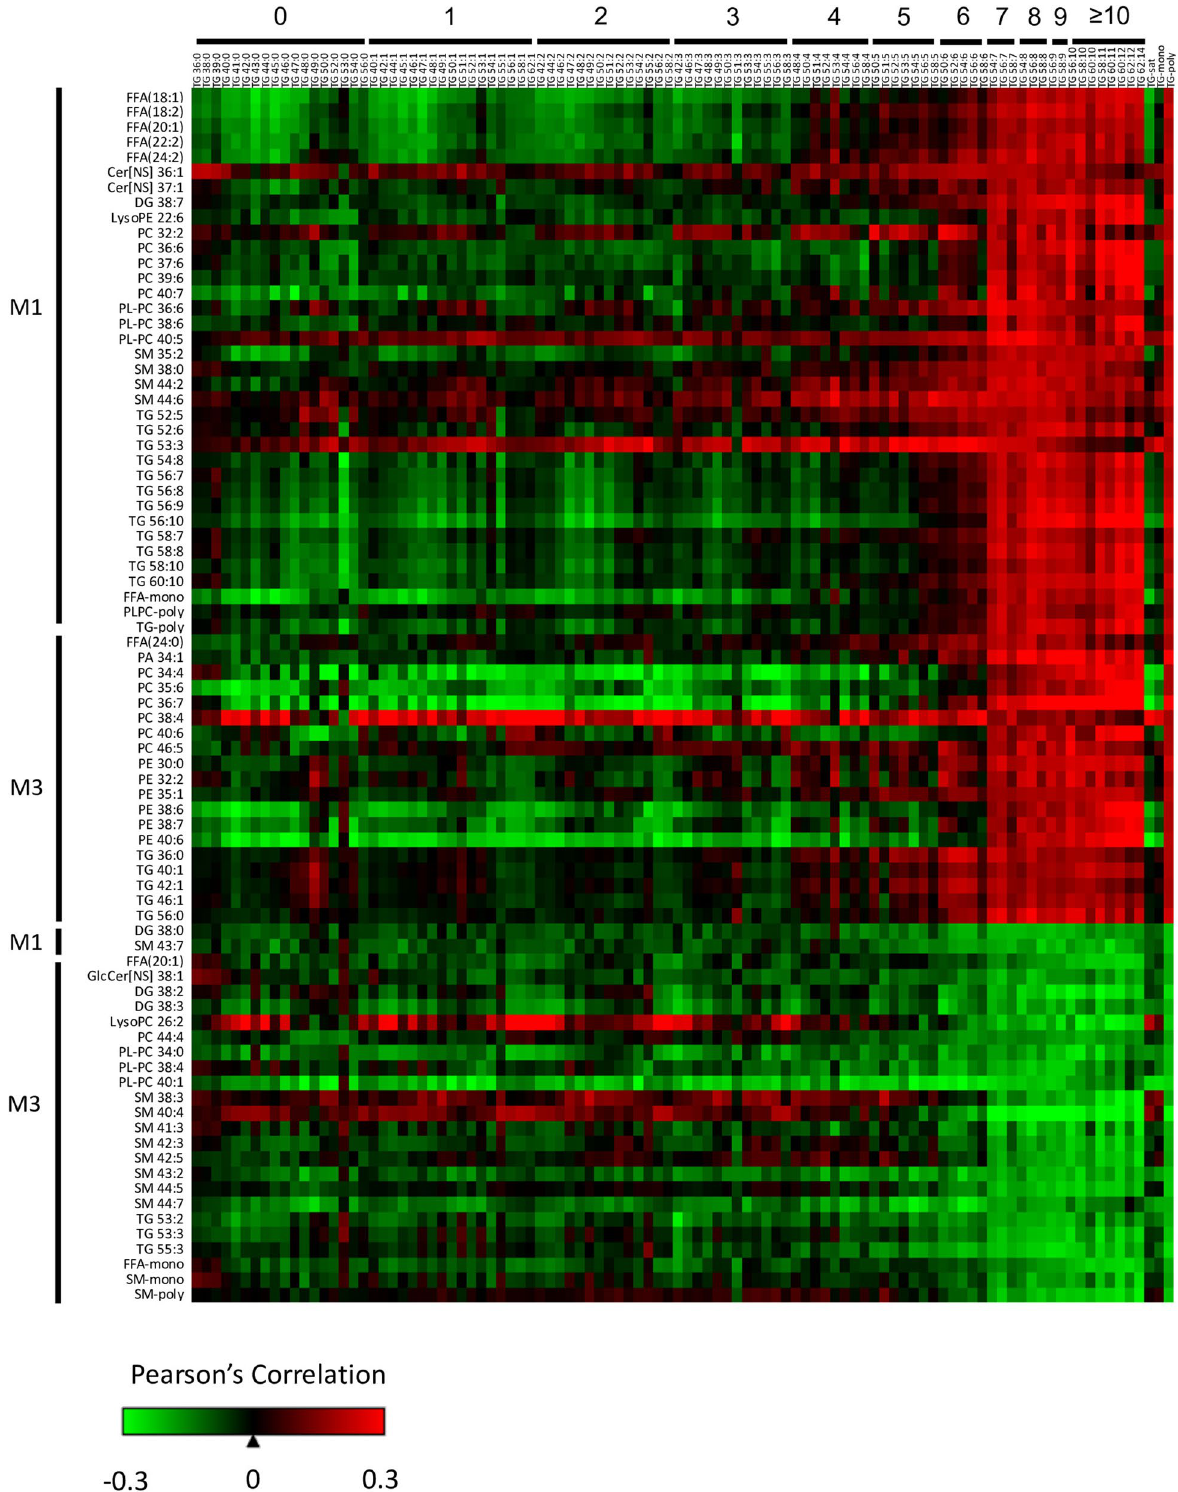
Figure 7. Maternal lipids correlate with cord blood polyunsaturated triglycerides. The association between maternal individual lipids and lipid groups with CB TGs was classified using Pearson’s correlations. Maternal lipids listed were significantly correlated with the lipid group CB TG-poly (unadjusted p-value α = 0.05). Maternal lipids (rows) are broken down by positive and inverse associations. Cord blood triglycerides (columns) are ordered by increasing chain length and number of double bonds. CB lipids groups TG-sat, TG-mono, and TG-poly are listed as the last three